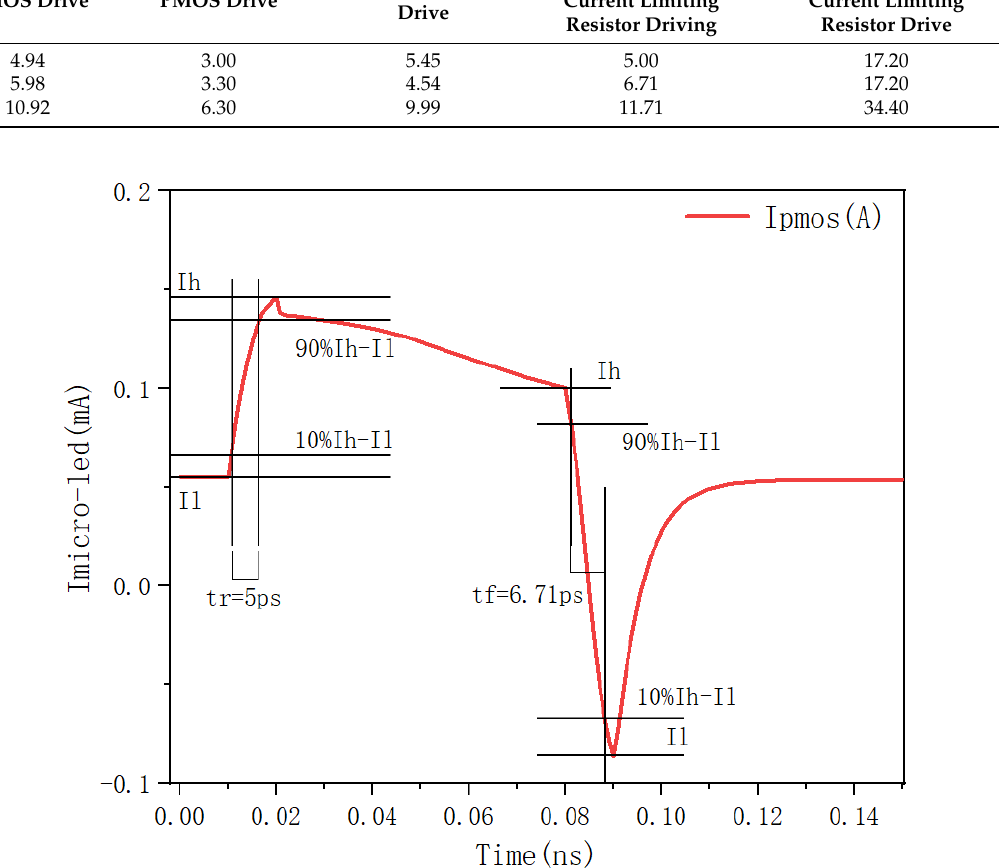
Figure 17. Analysis of rising time and falling time of the output current curve of the micro-LED driven by the PMOS current limiting resistor with time.